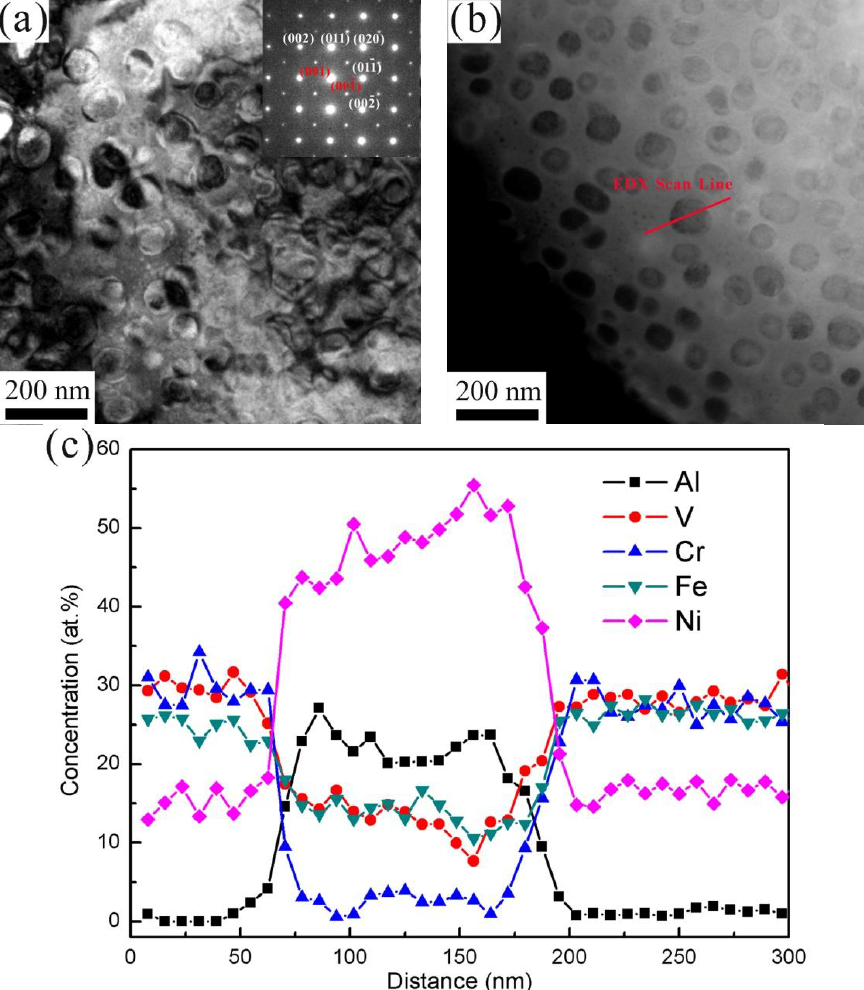
Figure 3. ( a ) BF TEM image of the Al 0.3 CrFeNiV alloy and corresponding SAED patterns (zone axis [100]) showing the alloy consisted of a B2 phase, and an A2 phase; ( b ) STEM-HAADF image, where the red line indicates the EDX scan line; ( c ) Compositional profiles across the nano-precipitates.